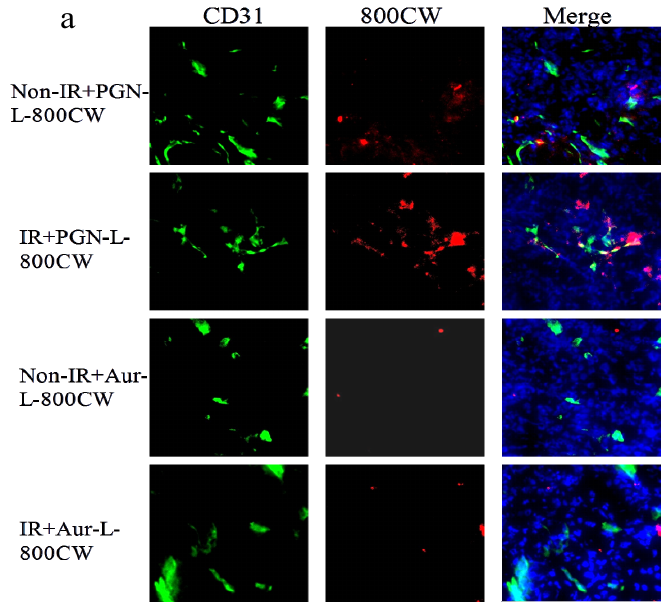
Figure 6. Fluorescence microscopic detection of the liposomal nanoprobes in non-irradiated or irradiated gliomas. Fluorescence microscopy with NIR filters was applied to detect 800CW signals. ( a ) Frozen sections of non-irradiated or irradiated tumors were examined for the presence of CD31 (green), 800CW (red), or DAPI (blue). Significantly more 800CW signals were observed in the PGN-L-800CW treated tumors than that in the control Aur-L-800CW tumors. Irradiation induced more PGN-L-800CW bound to exposed PS. Co-localizations of 800CW with tumor vascular endothelial cells (CD31) were primarily observed for PGN-L-800CW; ( b ) Quantitative data showed that 25% ± 6% of non-irradiated tumor vascular endothelial cells were co-stained with PGN-L-800CW, which increased to 60% ± 8% after irradiation. By contrast, minimal Aur-L-800CW signals were detected from either non-irradiated (0.7% ± 0.1%) or irradiated (0.9% ± 0.2%) tumors.